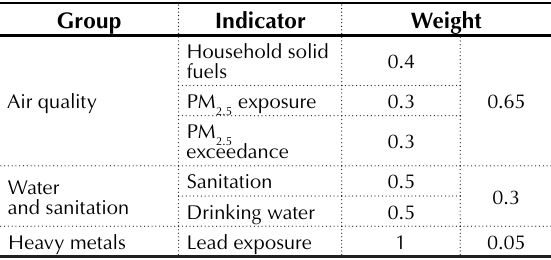
Table 2. Environmental Performance Index: the main indicators of policy objective – environmental health